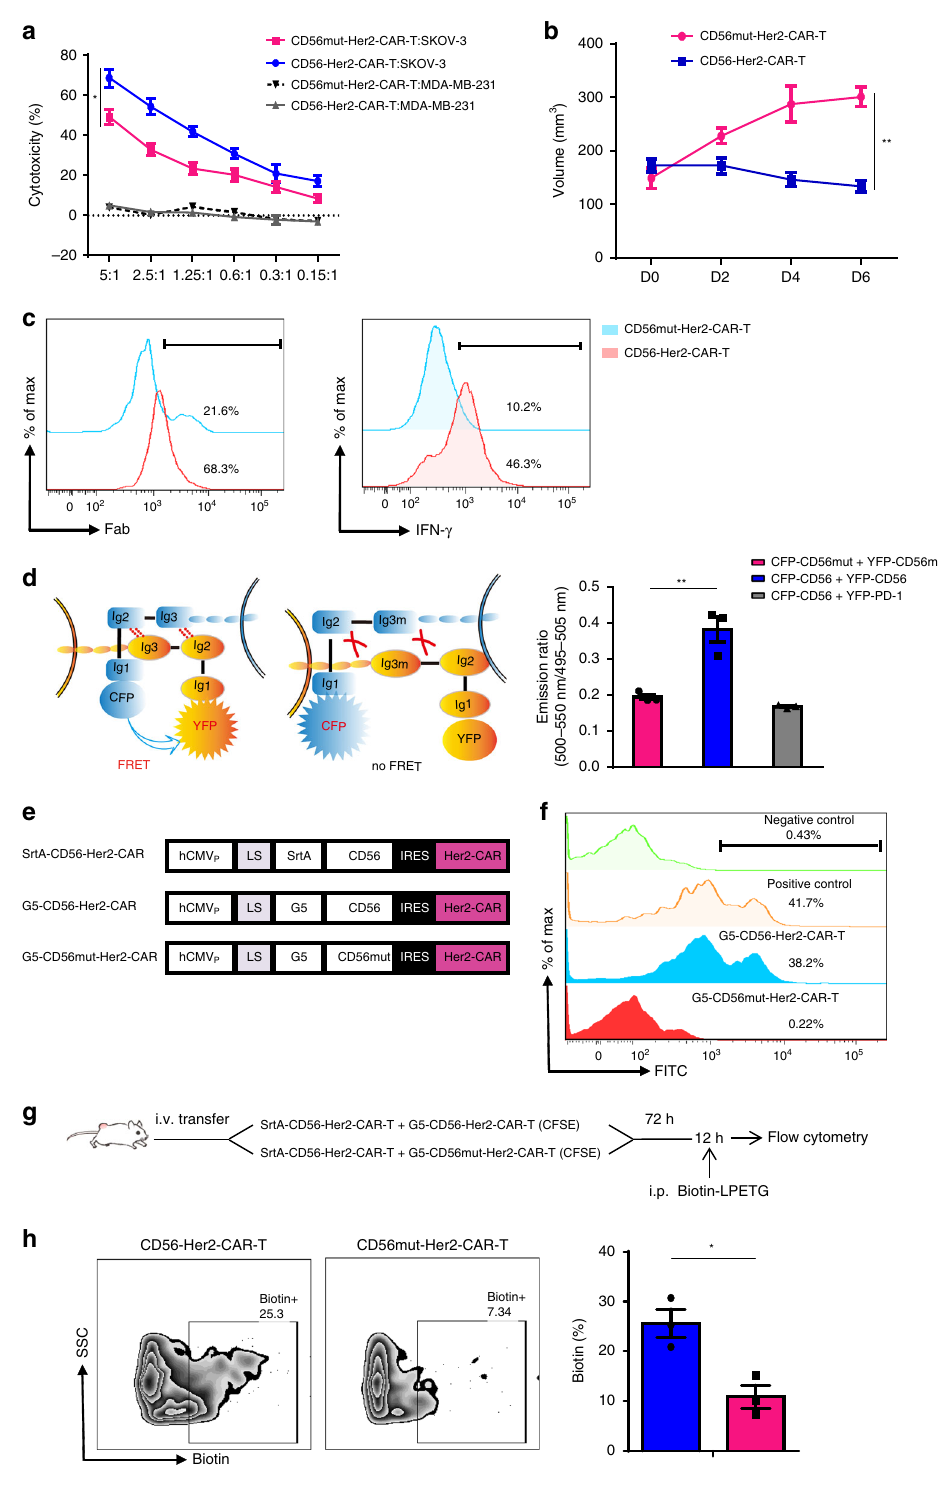
Methods Cell lines . HEK293T, SKOV3, and MDA-MB-231 cell lines were obtained from ATCC and cultured in Dulbecco ’ s modi fi ed Eagle medium (Gibco, Invitrogen, Carlsbad, CA) supplemented with 10% fetal bovine serum (FBS) (Gibco, Invi- trogen, Carlsbad, CA). SKOV3/ luc/RFP cells were established by the infection of SKOV3 with recombinant retroviruses carrying luciferase-IRES-RFP moiety, followed by sorting RFP high cells. Raji cells were also obtained from ATCC and cultured in RPMI 1640 (Gibco, Invitrogen, Carlsbad, CA) supplemented with 10% FBS (Gibco, Invitrogen, Carlsbad, CA). All cell culture media contained 100 U ml − 1 penicillin and 100 μ g ml − 1 streptomycin. Cells were maintained in a humidi fi ed atmosphere containing 5% CO 2 at 37 °C. As the routine cell lines